Question: Draft a figure caption describing what is shown.
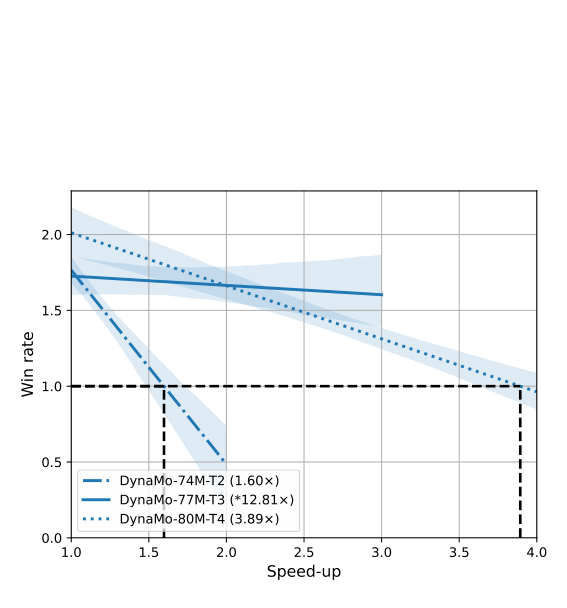
Answer: shows the win rates with respect to speed- ups on the sentence-completion benchmark using pairwise analysis against Pythia-70M (see Sec- tion 3.4 and Appendix A.3). DynaMo-77M-T3 shows much better win rates relative to DynaMo- 74M-T2 for speed-ups < 2.0 despite similar PPL1:2. Further, DynaMo-77M-T3, being a three-token model, can provide much higher speed-ups than DynaMo-74M-T2, however, at the cost of a slight parameter overhead. Since the extra parameter overhead is marginal, especially for larger mod- els, we stick with three-token models. We also explore simultaneous token prediction beyond the three-token model. Fig. 6 also shows the performance of DynaMo-80M-T4. Due to the better transformer training through the modified- CLM objective, the four-token model achieves higher win rates than the three-token counterpart for speed-ups < 2.0. DynaMo-80M-T4 achieves a same-quality speed-up of 3.89×, however, at an ad- ditional parameter overhead. Apart from the param- eter overhe